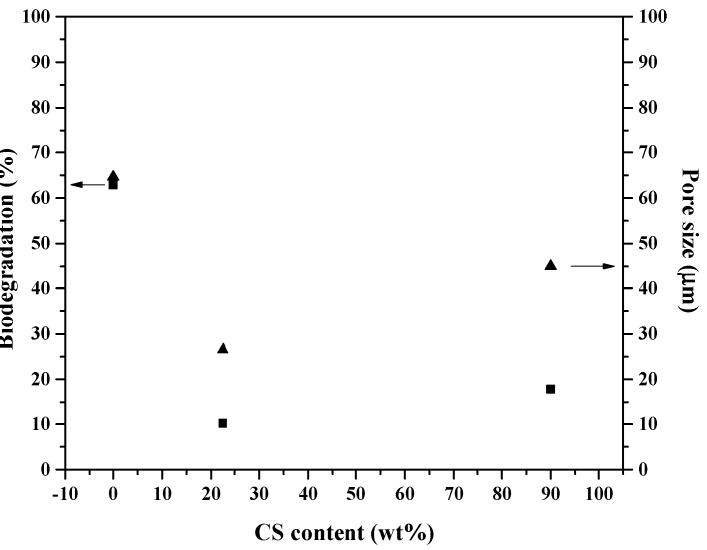
Figure 9. Correlation between biodegradation and pore size of composite scaffolds as the function of CS content.